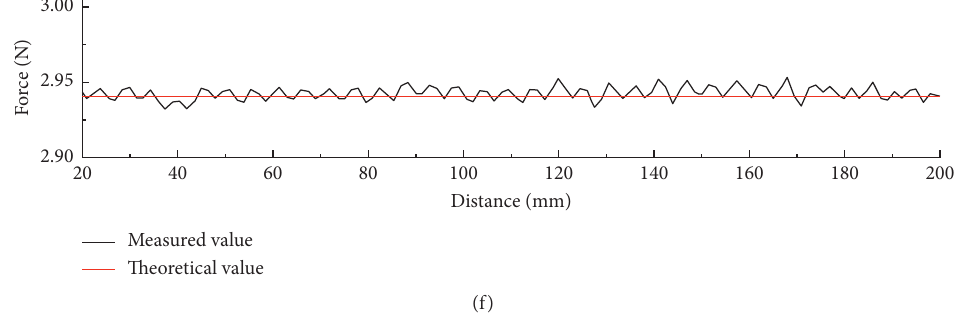
Figure 25: Comparison of thrust at different motor speeds with a load of 0.3kg: (a) 0.3 kg, 0.05m/s; (b) 0.3kg, 0.06 m/s; (c) 0.3kg, 0.07m/s; (d) 0.3kg, 0.08m/s; (e) 0.3kg, 0.09m/s; (f) 0.3kg, 0.1m/s. Table 6: Thrust fluctuation rate of motor at different speeds when the load is 0.3kg. Speed (m/s) Measured thrust